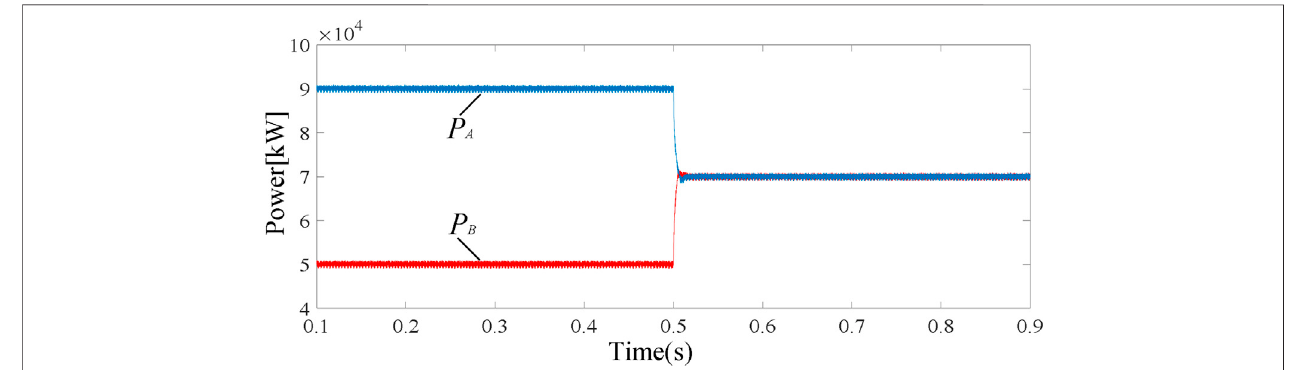
FIGURE 4 | Active power of AC grids A and